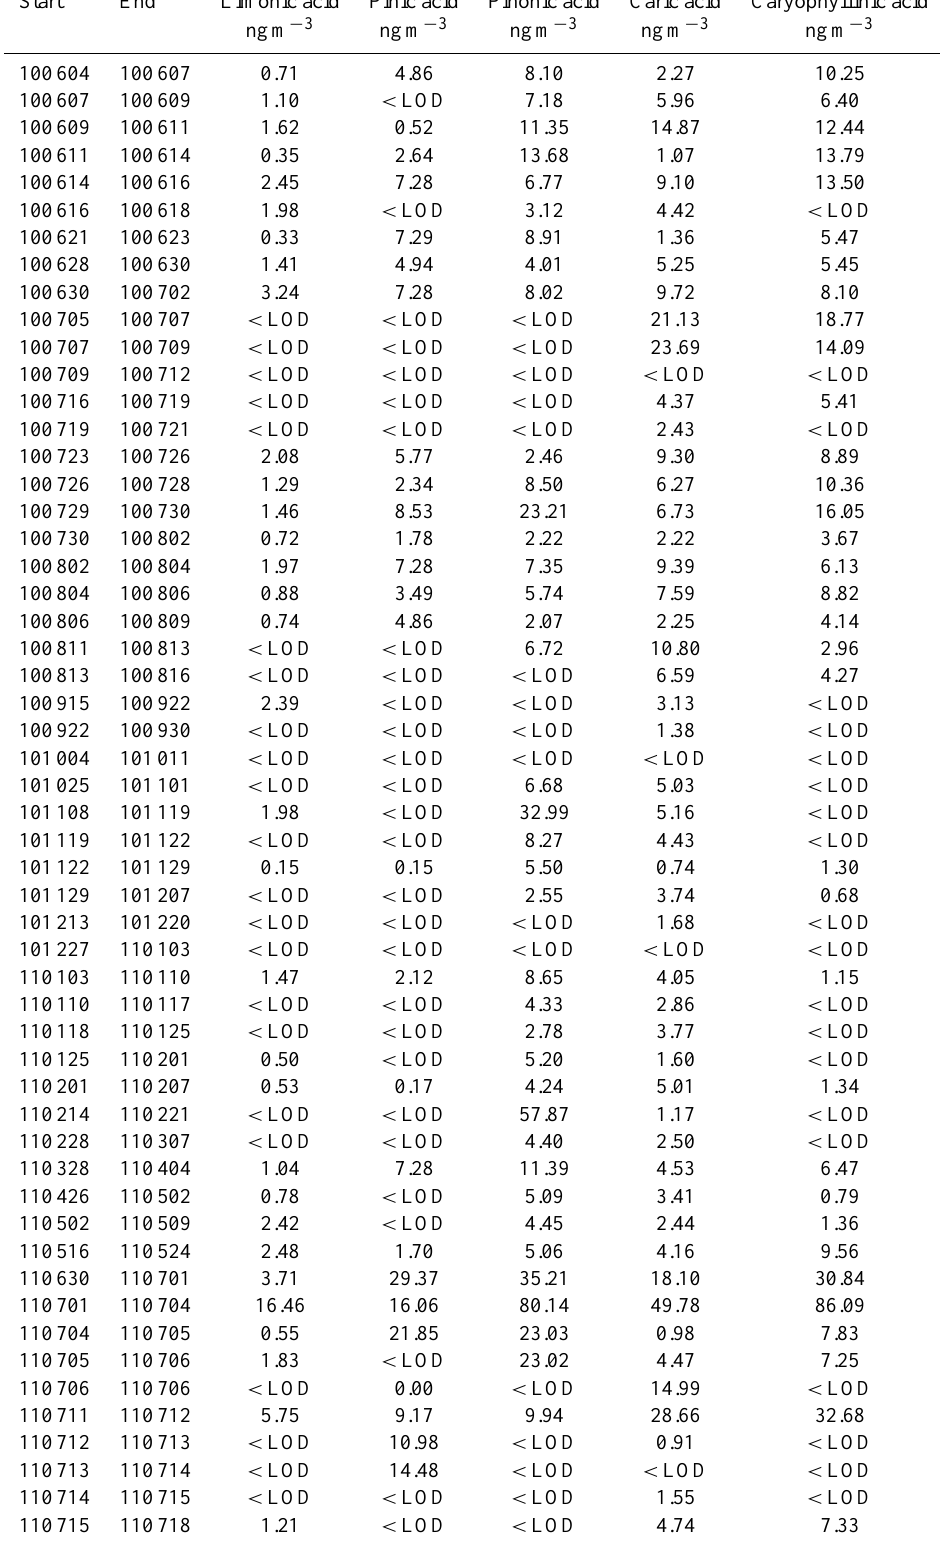
Table 3. Sampling dates and acid concentrations of all